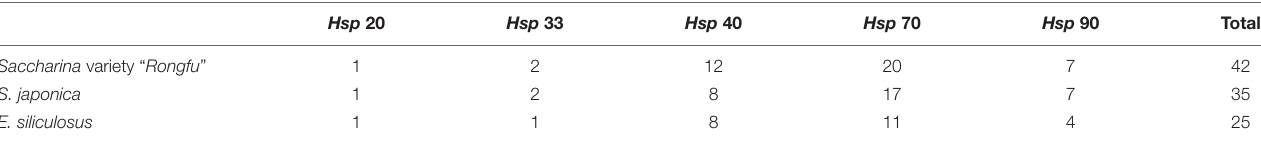
TABLE 5 | Gene number of Hsp gene families in sequenced Saccharina variety “Rongfu,” S. japonica and E. siliculosus . Hsp 20